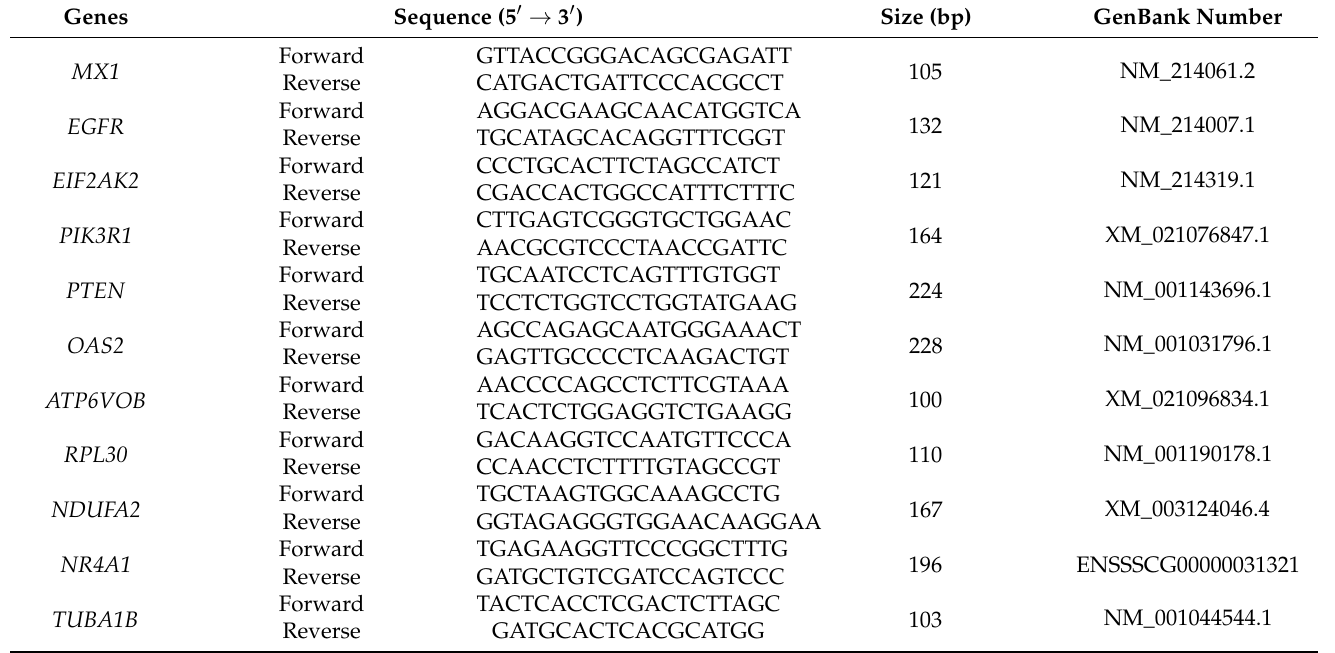
Table 4. Primers used for